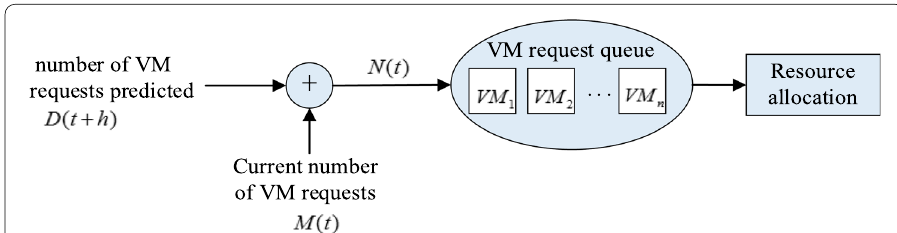
Fig. 3 Proactive resource allocation strategy. The RT-based adaptive prediction method is used to predict the future VM requests based on past data. A hybrid VM request queue is formed by combining the future